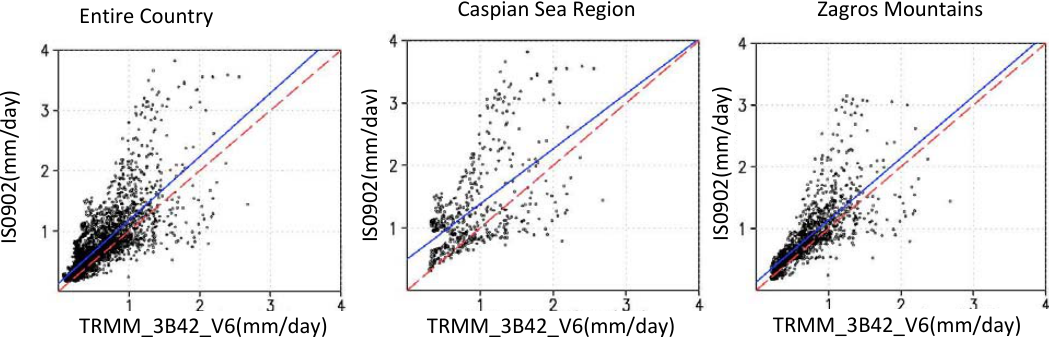
Fig. 7. Scatter plots of annual average of rainfall from IS0902 versus TRMM 3B42 for each 0.25 ◦ × 0.25 ◦ grid cell (a) the entire country, (b) the Caspian Sea Region, (c) the Zagros Mountains. Table 1. Statistical parameters of linear regression and spatial correlation coefficient in Fig. 7. “*” denotes significance level of derived spatial correlation is 99%.